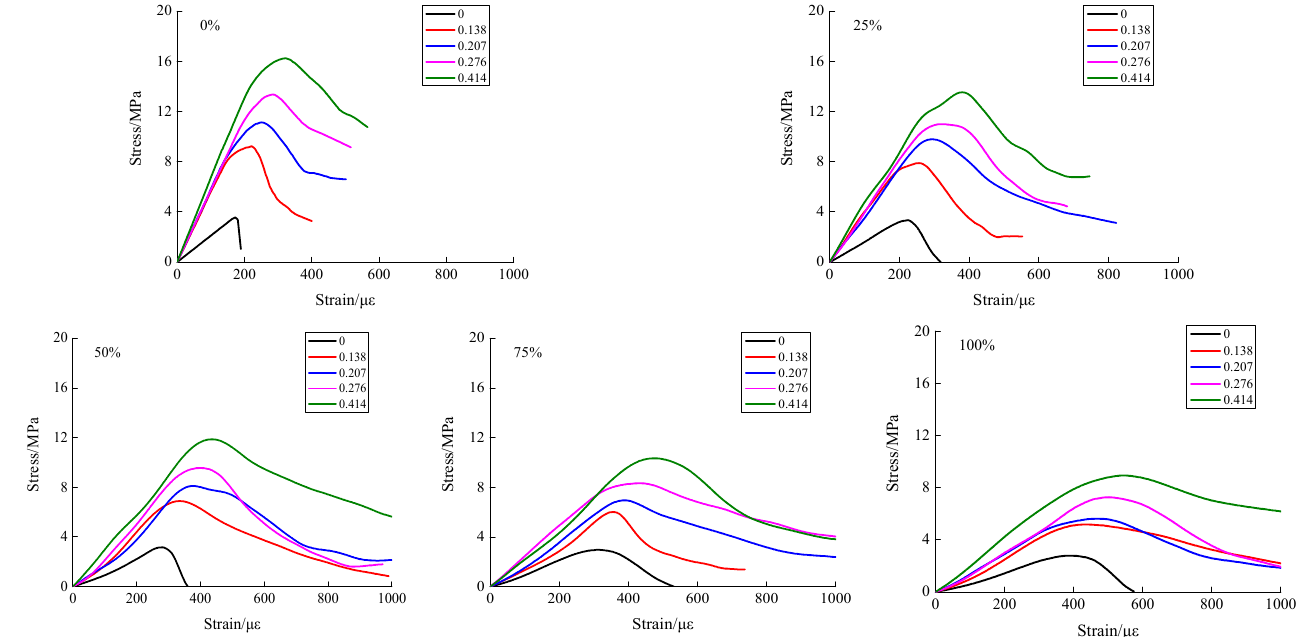
Figure 4. Shear stress–strain curves of recycled concrete with different replacement rates.